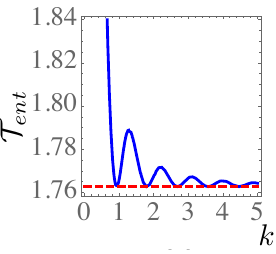
(b) ( k ) for the phase-flip process for qubit T ent I ) [ . . . ] = γ ( σ z [ . . . ] σ z i ω [ σ x , . . . ] . On 2 L − −